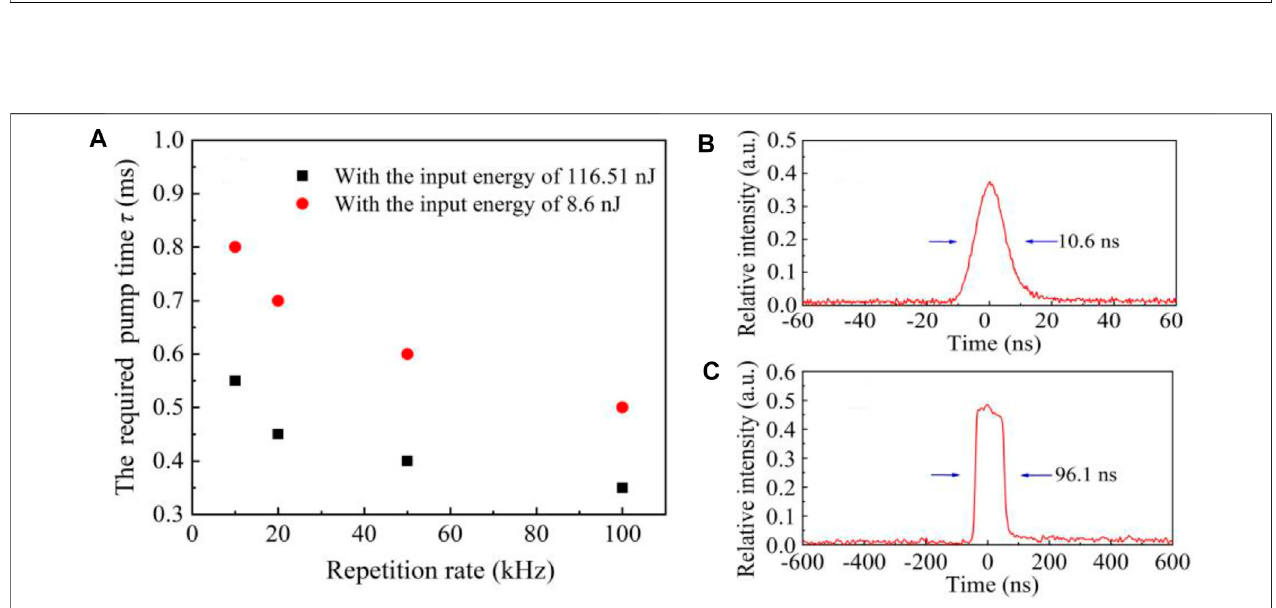
FIGURE 8 | (A) Pump time τ versus repetition rate at stable burst pro fi le distribution for different input energy. (B) Recorded output single-pulse pro fi le at the 100 kHz repetition rate with a pulse width of 10.6 ns. (C) Recorded output single-pulse waveform at the 100-kHz repetition rate for pulse duration with 96.1 ns.